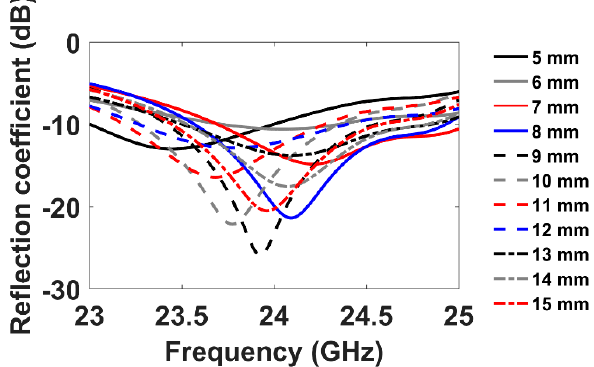
Figure 8. Simulated reflection coefficient of the designed Doppler radar antenna with Duke phantom.